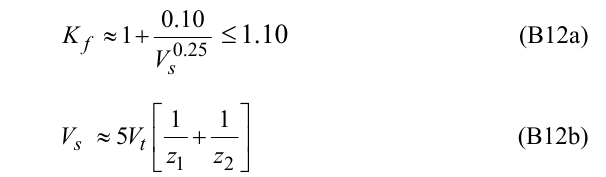
Table A1: Basic Mounting Factor [16, p667] Gear Mounting Type